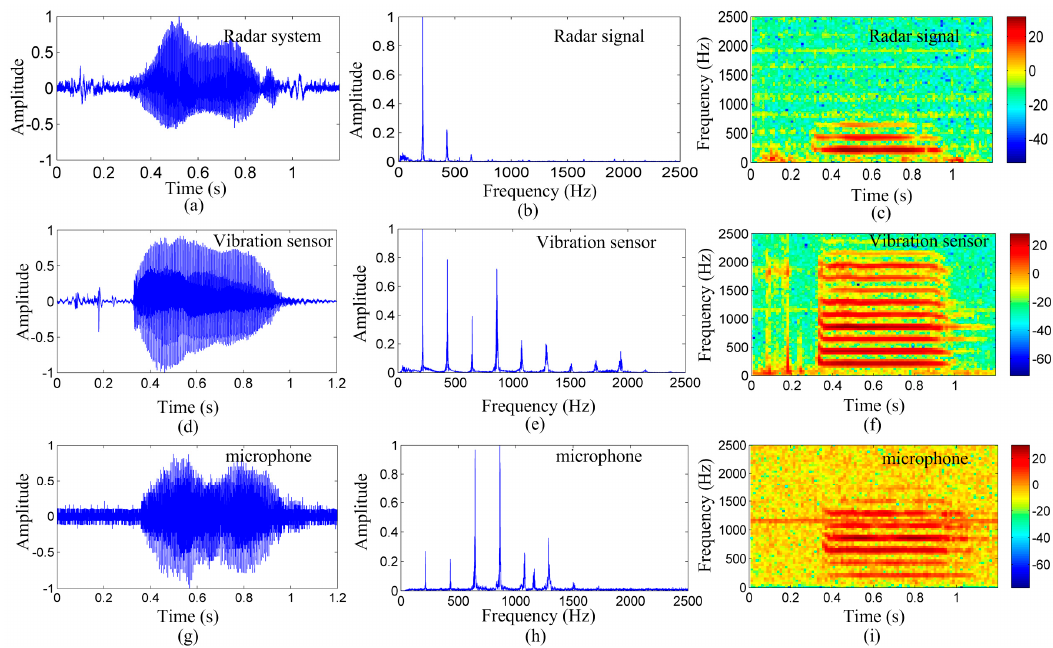
Figure 5. Measurement results of the radar system, vibration measurement sensor, and microphone system for the vowel /a/, as spoken by a young male subject. Time-domain waveforms, frequency-domain spectrum, and spectrograms of the ( a – c ) signal detected by the radar system, respectively; ( d – f ) signals detected by the vibration sensor, respectively; and ( g – i ) signal detected by the microphone system, respectively. From the spectrogram, the signal strengths of the different spectra over time are apparent. The color depth shows the signal energy value; the darker the color, the stronger is the signal energy.